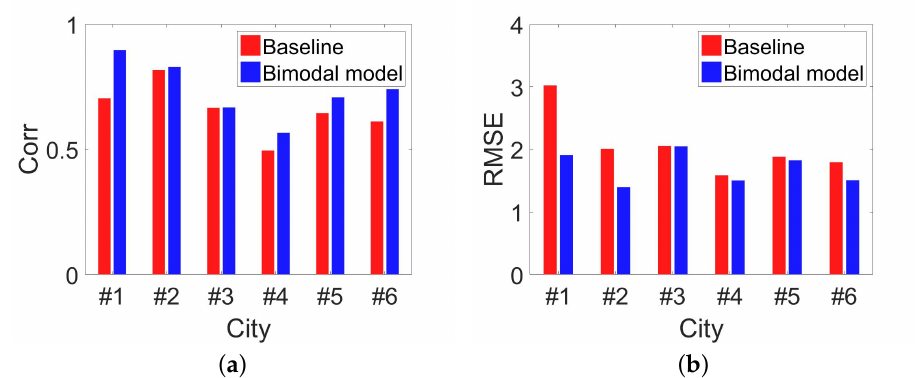
Figure 8. Precision assessments of baseline model and bimodal model. We can see that bimodal model performs better than the baseline model in all the cities. ( a ) Correlation between estimated population with ground-truth among 6 cities by baseline model and bimodal model; ( b ) RMSE of estimated population for baseline model and bimodal model in 6 cities.